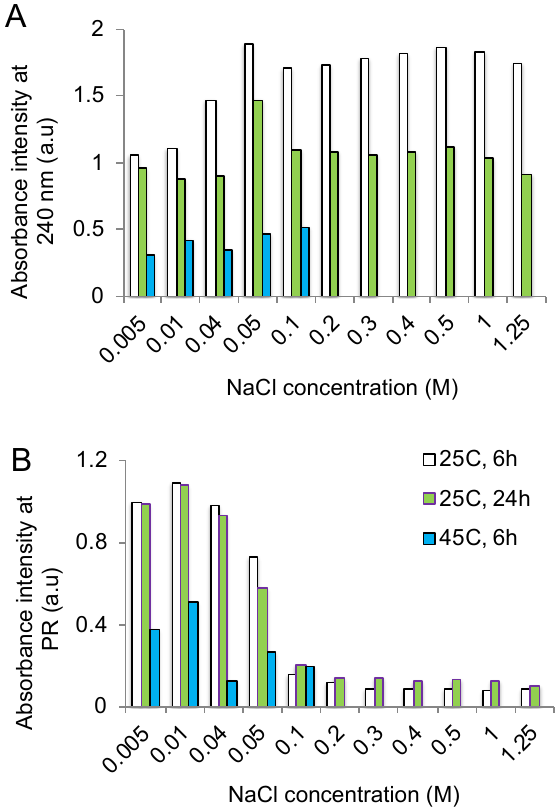
Figure 6. ( A ) Absorbance intensity at 240 nm and ( B ) the maximal absorbance intensity of the PR peak in the mixtures of 0.25 mM HAuCl 4 and 6.3% w / w F127 as a function of the NaCl concentration after incubation of the reaction mixture at 25 °C or 45 °C at 6 h and 24 h.